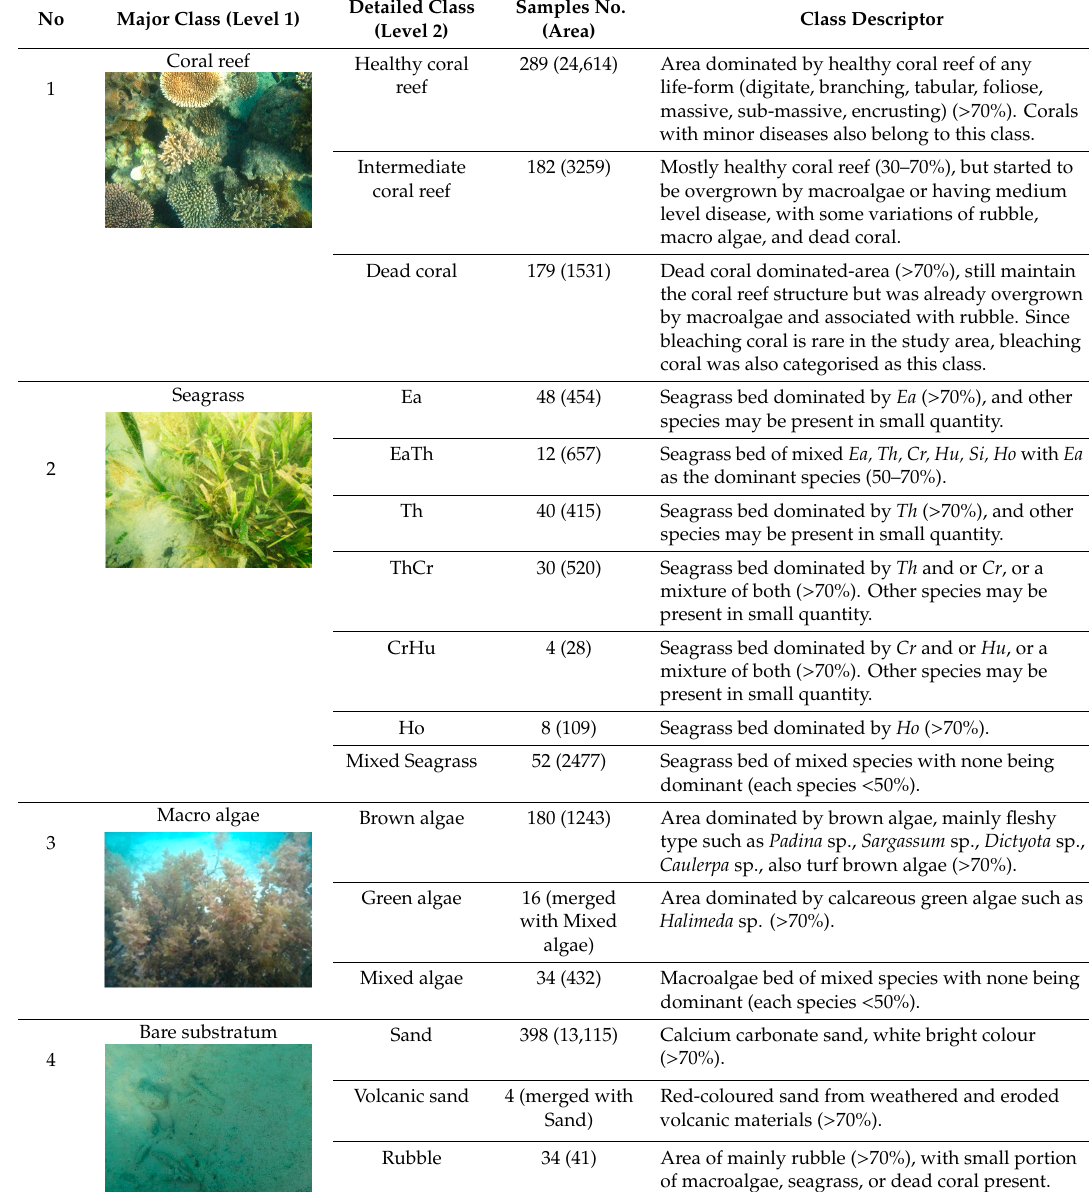
Table 3. The classification scheme of benthic habitats used in this research along with the number of samples. The numbers in bracket are the number of pixels obtained from the extrapolation of point samples into area samples based on image segmentation result resampled to WV2 pixel size (4 m 2